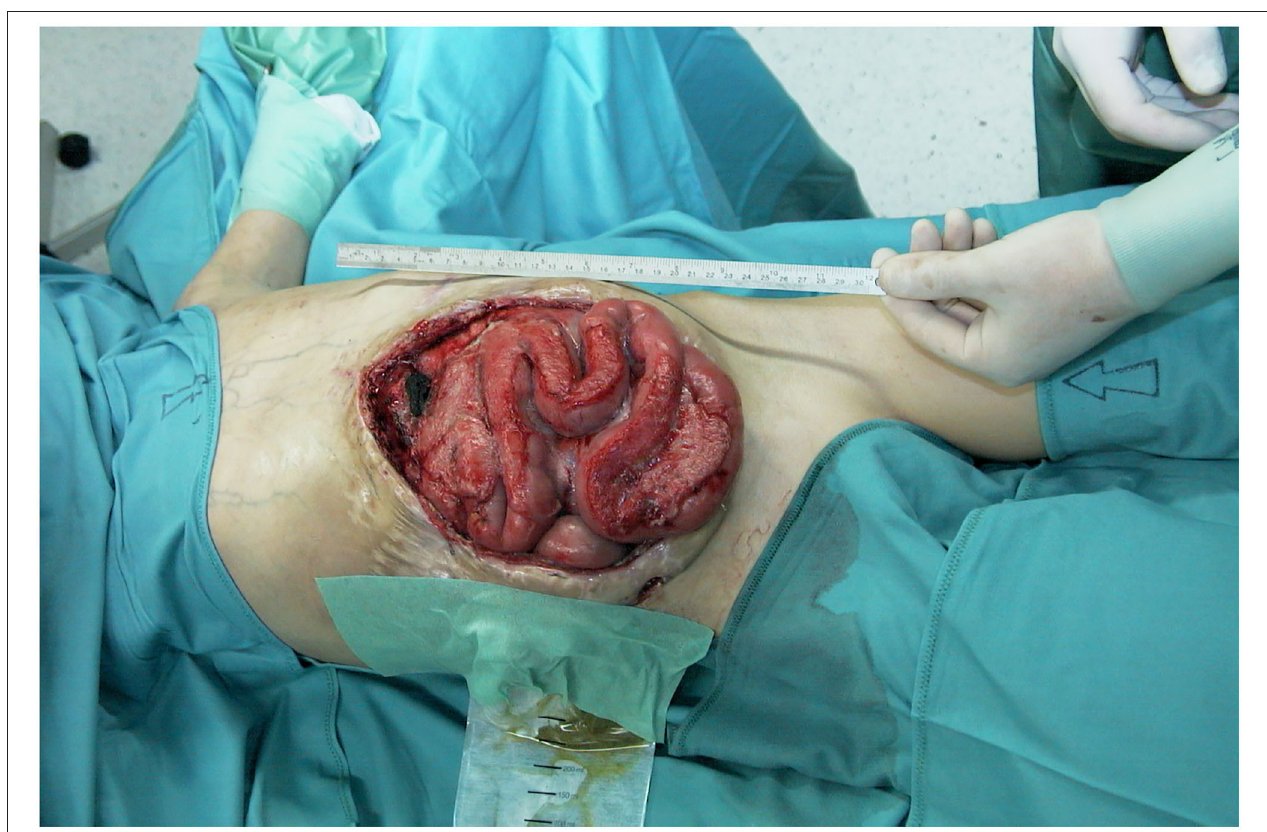
FIGURE 9 | Preoperative view of the immense abdominal wall defect (24cm × 20cm) of an 11 years old boy after second bowel